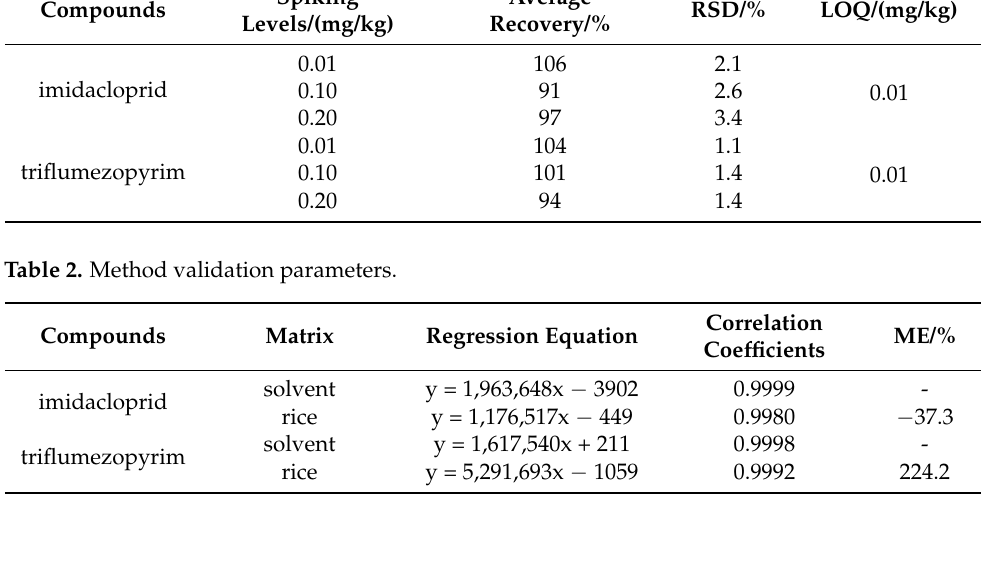
Table 1. Average recoveries and RSDs at three spiked levels.